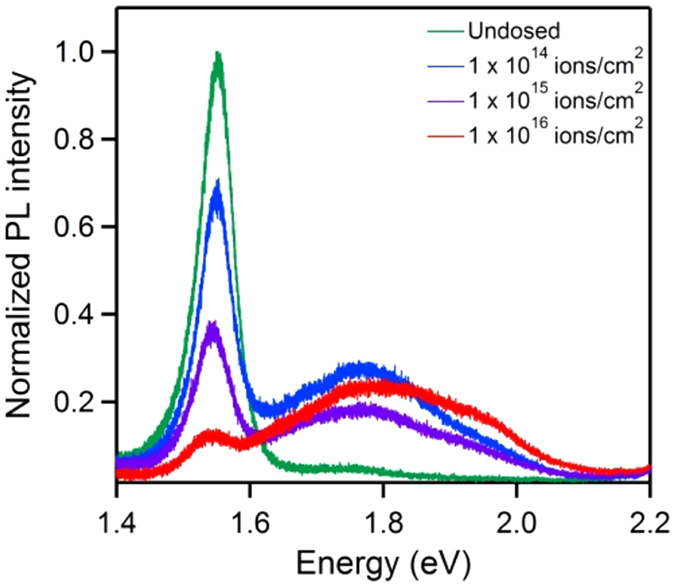
Photoluminescence (PL) spectra of supported MoSe2 indicating the evolution of the A-exciton (~1.55 eV) and B-exciton (~1.77 eV) peaks in undosed region (green trace) and He+ beam-irradiated regions corresponding to doses of 1 × 1014 ions/cm2 (blue trace), 1 × 1015 ions/cm2 (purple trace), and 1 × 1016 ions/cm2 (red trace).